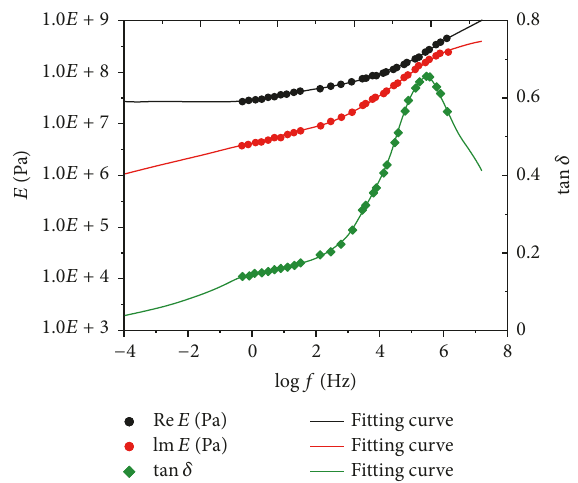
Figure 3: Master curves of complex modulus for tread rubber material.